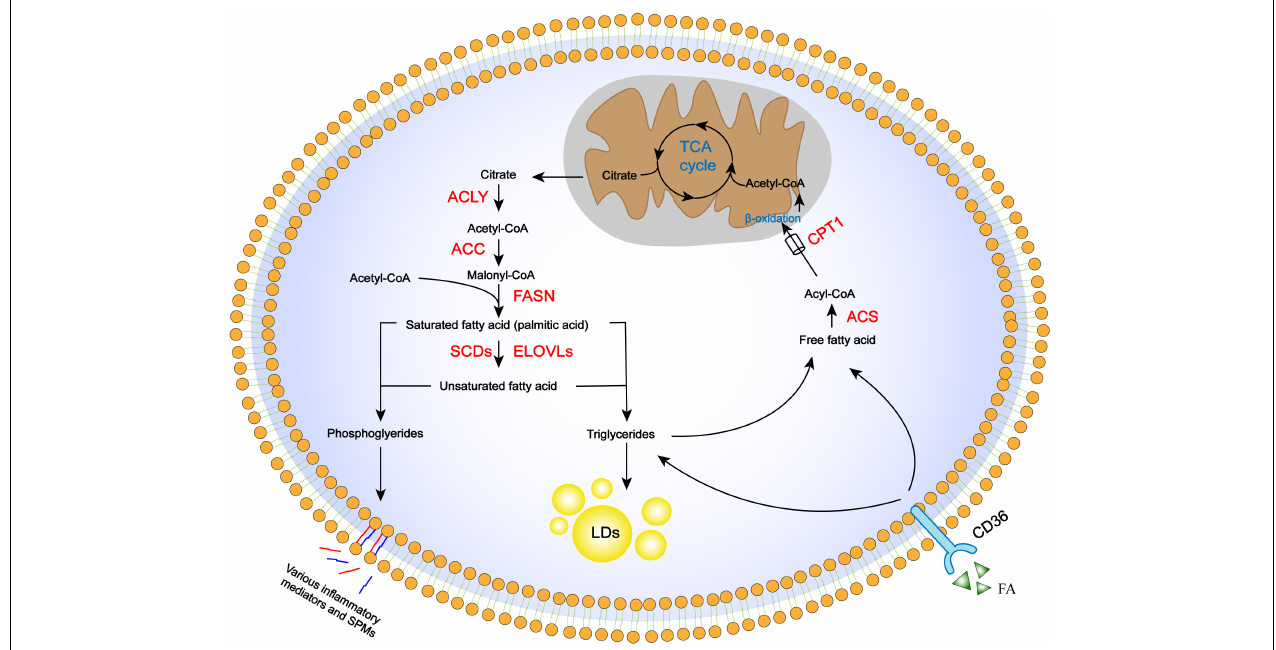
FIGURE 1 | Regulation of FA metabolism pathways, including anabolism, storage, uptake, catabolism, and derivation. De novo FA synthesis occurs in the cytoplasm, where citrate is converted in the TCA cycle to the final long-chain saturated or unsaturated FA. These steps involve ACLY, ACC, FASN, and desaturases, as well as elongation proteins. Once synthesized, FA is stored in lipid droplets as triglycerides or mobilized through β -oxidation to provide energy and acetyl-CoA. Acetyl-CoA is used again in the TCA cycle. Essential FAs are incorporated into cellular phospholipids and released from cell membranes to be converted into lipid-derived mediators. FAs from extracellular sources can also be used for storage or β -oxidation through the CD36